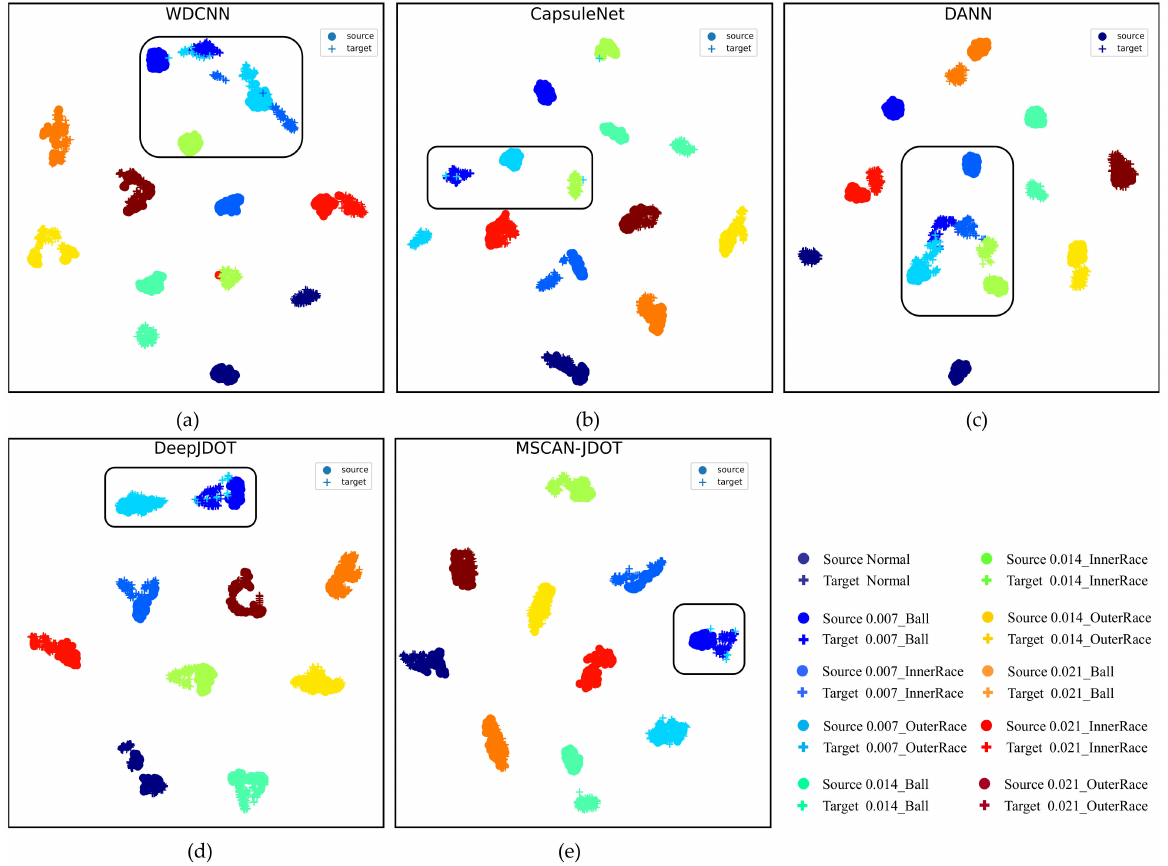
Figure 8. Visualization results of C-A domain-invariant features. Domain-invariant features of ( a ) WDCNN, ( b ) CapsuleNet, ( c ) DANN, ( d ) DeepJDOT, and ( e )